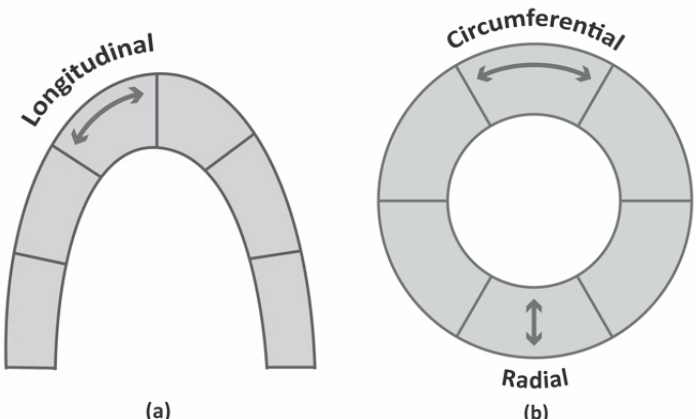
ening and diastolic stretching, while the radial strain shows systolic thickening and diastolic thin ‐